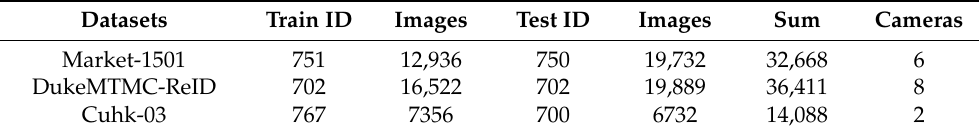
Table 1. Introduction to dataset.